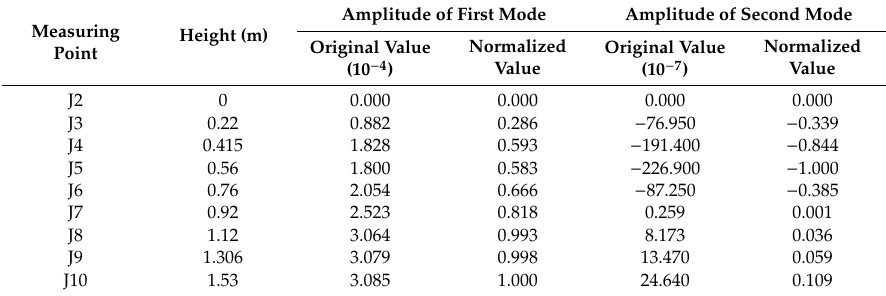
Table 6. Power spectrum peaks of the first and second mode in the without water condition.